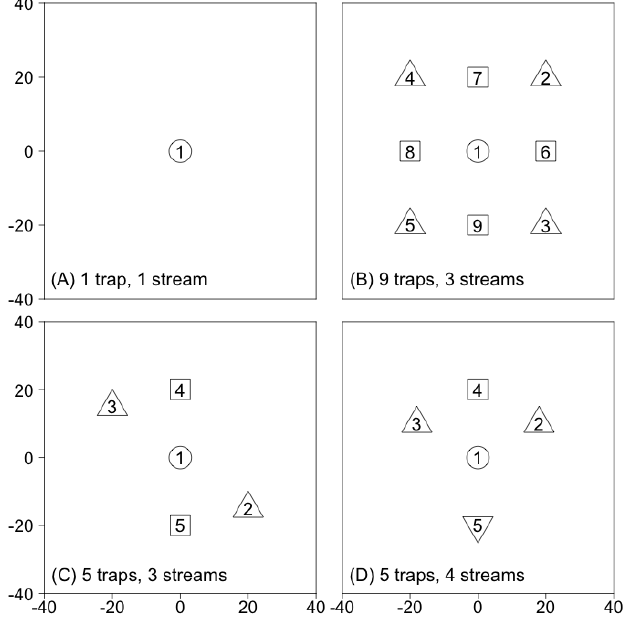
Fig. 2. Distribution of the traps on Ω for each setting. The symbols identify the traps that produce identical incoming streams within each